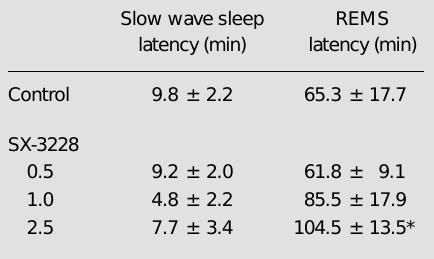
Table 1 - Effect of SX-3228 on sleep latencies during the light phase of the light-dark cycle. Data are reported as means ± SEM. Six animals were in each experimental group. The doses are reported as mg/kg. *P<0.05 compared to